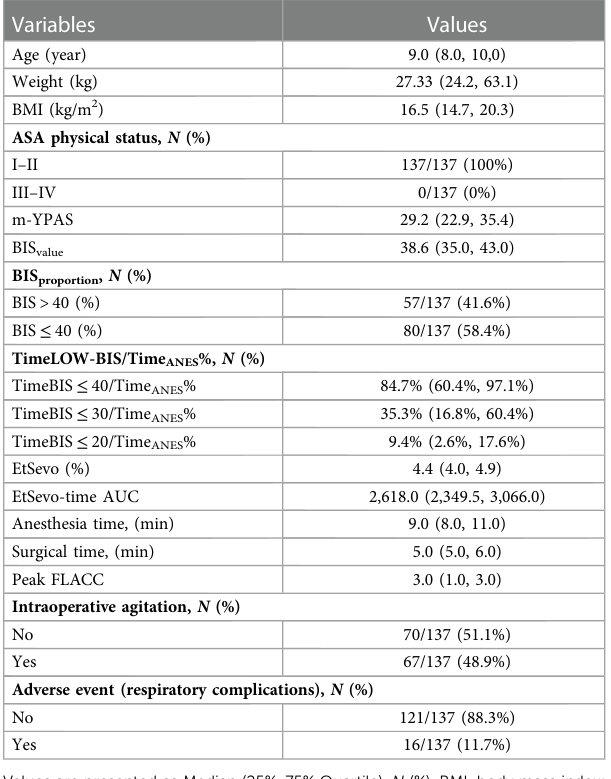
TABLE 1 Baseline and clinical characteristics of the included patients ( n =137).